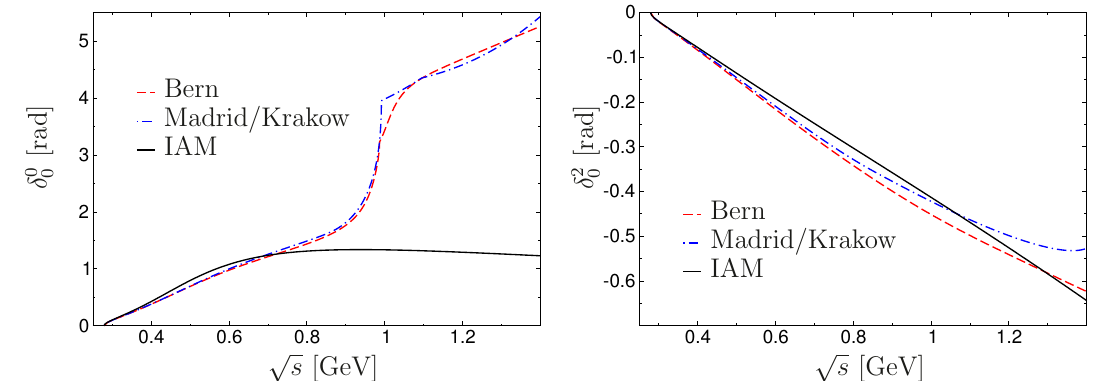
Figure 13. I = 0 (left) and I = 2 (right) (cid:25)(cid:25) S -wave phase shifts from the IAM (black solid line), in comparison to the Bern (red dashed line) [94, 124] and Madrid/Krakow (blue dot-dashed line) [125] Roy-equation